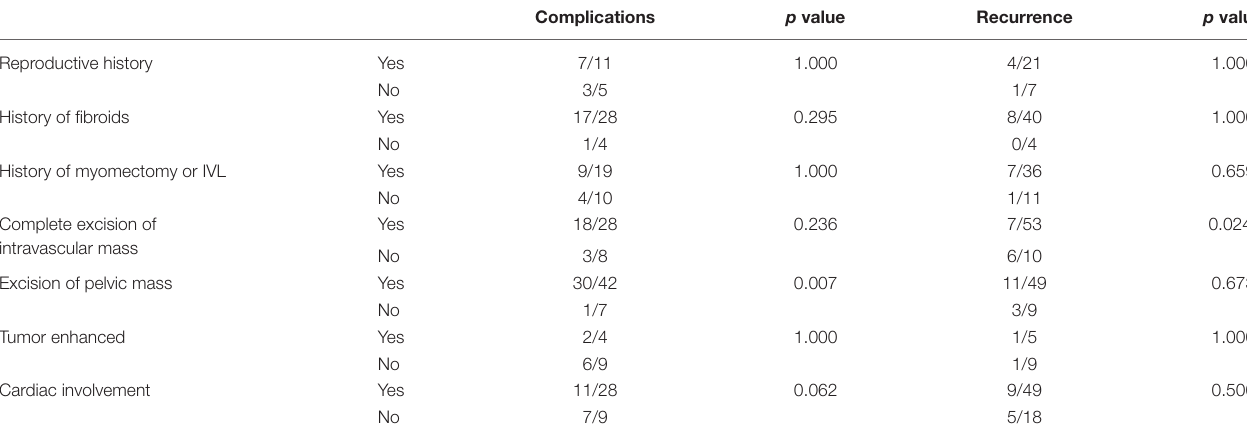
TABLE 3 | Factors associated with complications and recurrence of IVL.